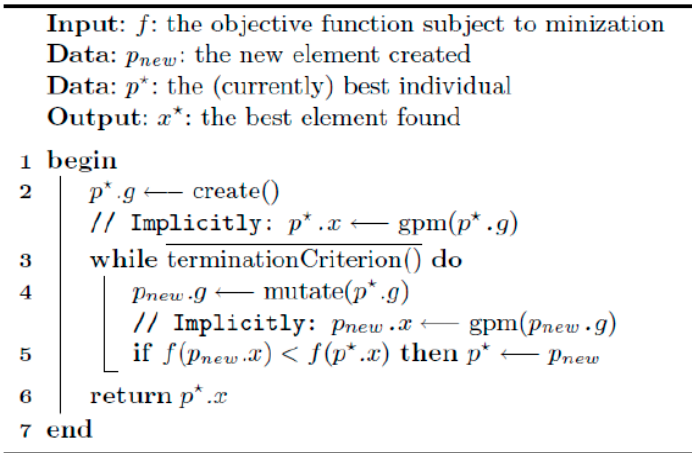
Figure 5. General procedure of hill climbing (HC) algorithm.